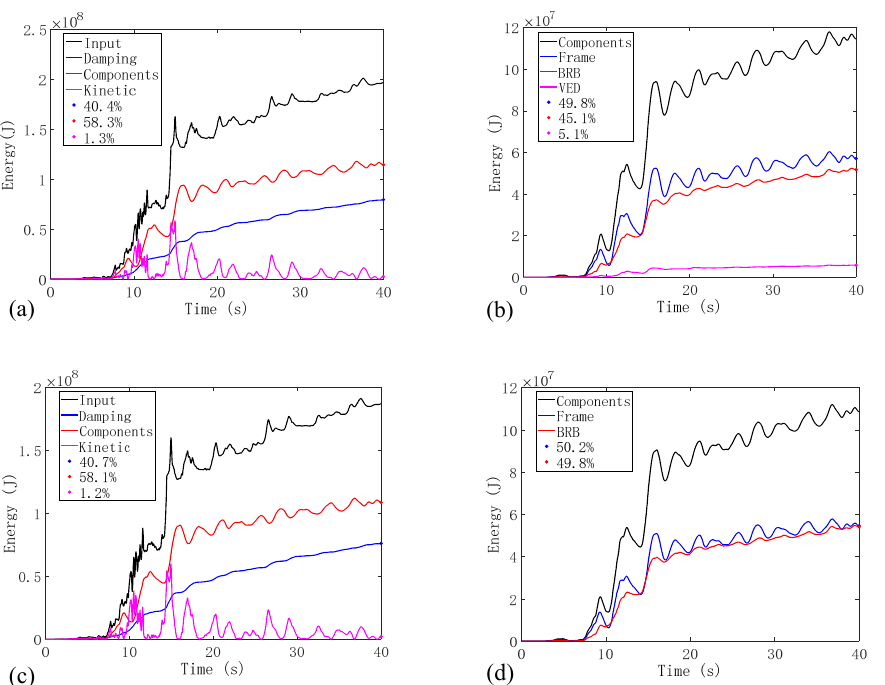
Figure 14. Seismic energy analysis (Loma Prieta case, PGA = 400 cm/s 2 ): ( a ) energy distribution (VBRB-BF); ( b ) energy absorbed by components (VBRB-BF); ( c ) energy distribution (BRB-BF); and ( d ) energy absorbed by components (BRB-BF).